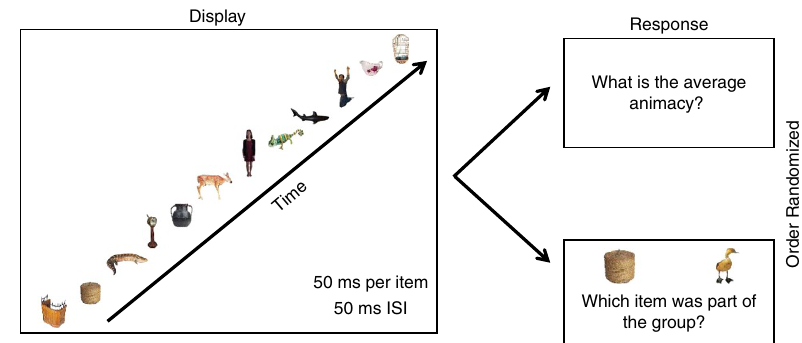
Figure 7 | Trial sequence for the whole set condition. First, participants viewed 12 random stimuli displayed sequentially for 50ms per item, with a 50ms ISI. Next, participants viewed a two-alternative forced choice membership identity task and participants were asked to rate the average lifelikeness of the group. Participants were not given a time limit to complete both tasks. The order of the two tasks was randomized throughout the experiment, so that sometimes participants performed the lifelikeness rating first and sometimes participants performed the membership identity task first.